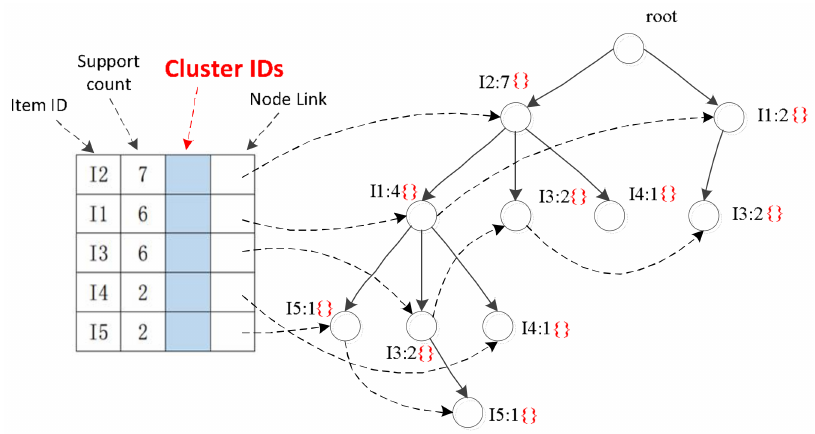
Figure 1. FP-GCID—novel FP-Growth algorithm based on Cluster